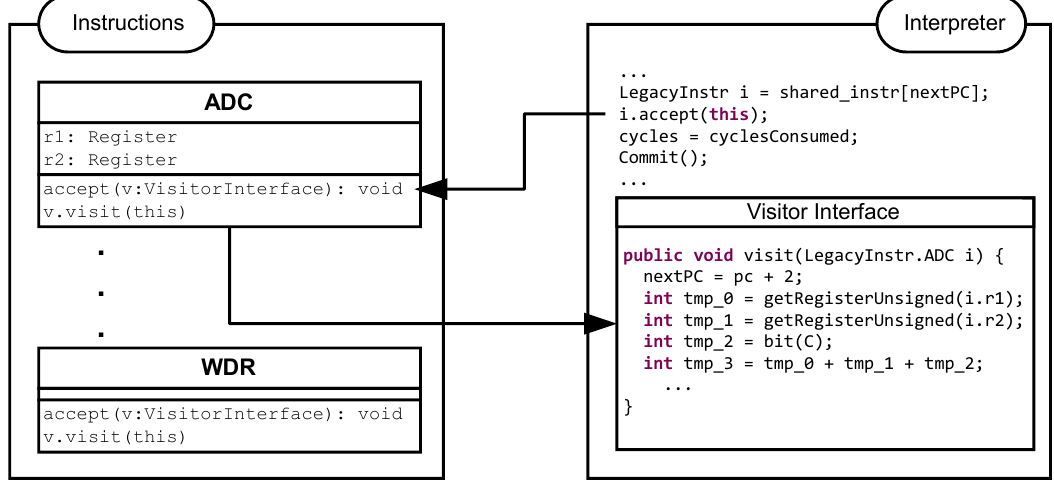
Figure 1: Avrora Instruction Classes and Interpreter